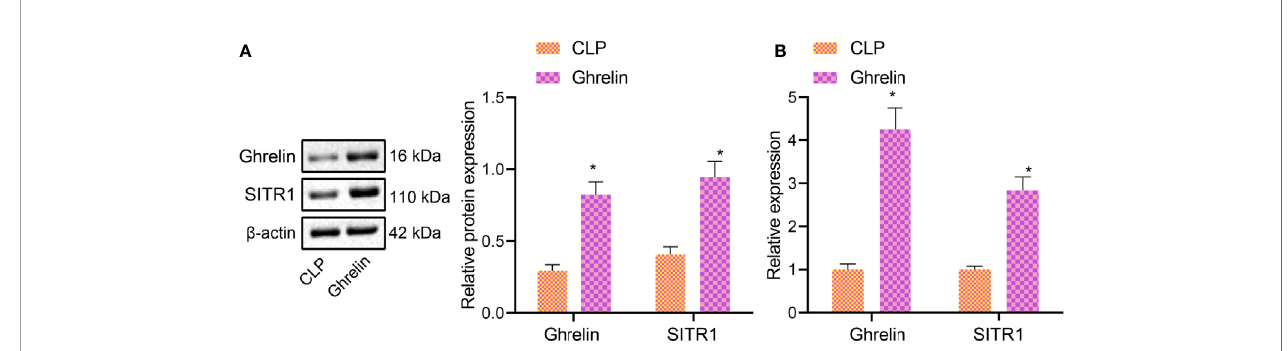
FIGURE 3 | Ghrelin activates SIRT1 expression. (A) , Western blot analysis detection of Ghrelin and SIRT1 protein expression in Caco-2 cells. (B) , RT-qPCR detection of Ghrelin and SIRT1 expression in Caco-2 cells. * p < 0.05 vs. CLP group. The measurement data were expressed as mean ± standard deviation. The independent sample t -test was used to compare data between two group.